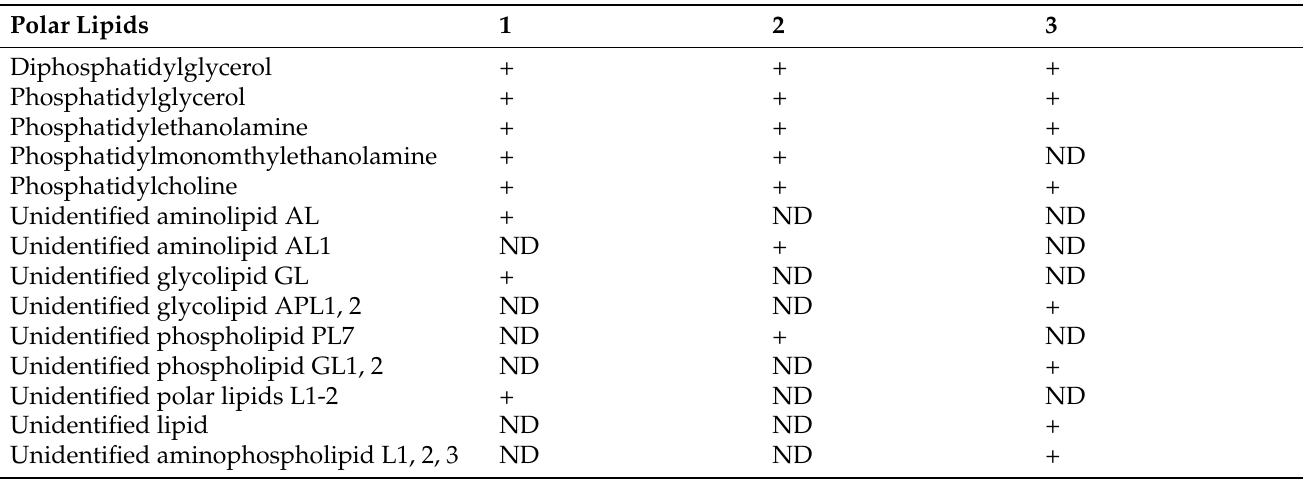
Table 5. Cellular polar lipids profiles of strain TDYN1 and its relatives. Strains: 1, TDYN1; 2, Falsochrobactrum ovis B1315 T [28]; 3, Falsochrobactrum shanghainese HN4 T [27]; +, positive; ND, no data. The results of TDYN1 were from this study, other data were from the